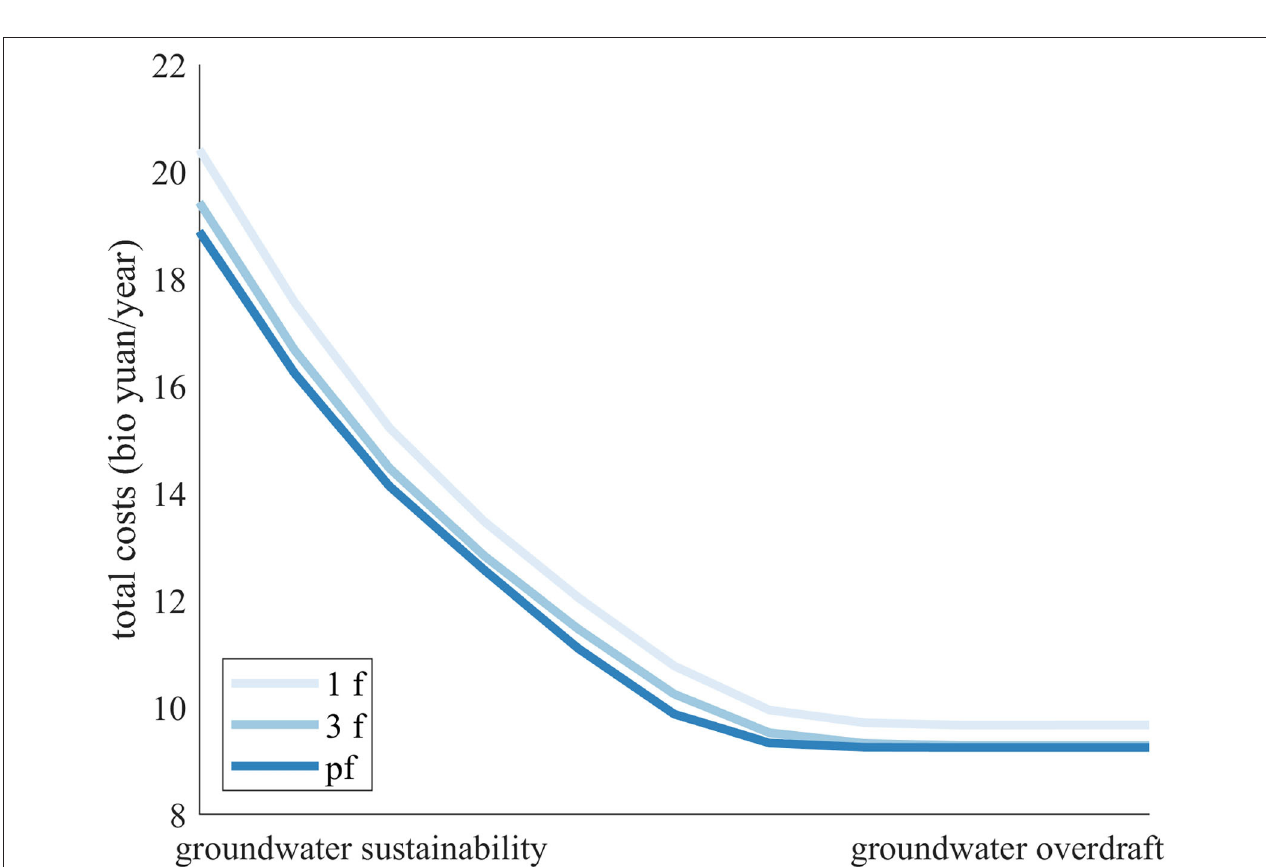
FIGURE 7 | Pareto optimal solutions ranging from sustainable groundwater abstractions to unlimited overdraft.